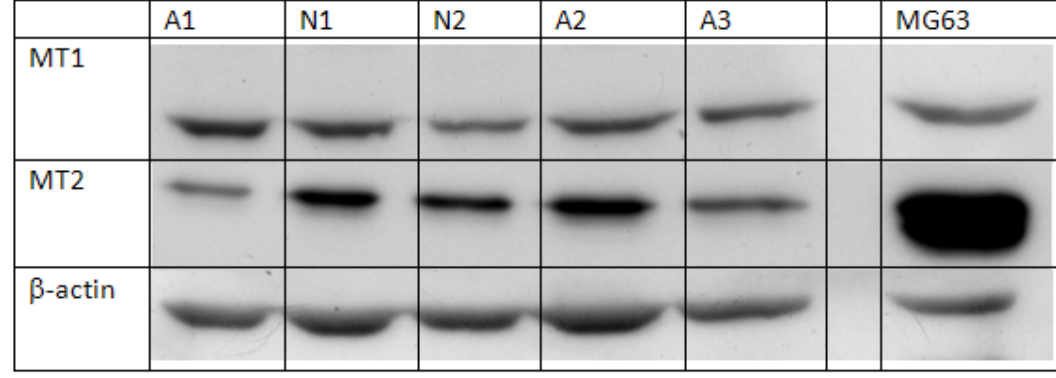
Figure 1. Representative image of protein expression of melatonin receptors in osteoblasts. Cells isolated from normal controls were cultured until confluence. Cells were then collected and lysed for analysis of protein expression of melatonin receptor MT1 and MT2. Beta-actin was used as an internal control, and protein from the cell line MG63 was used for positive control. N = normal control; A = AIS